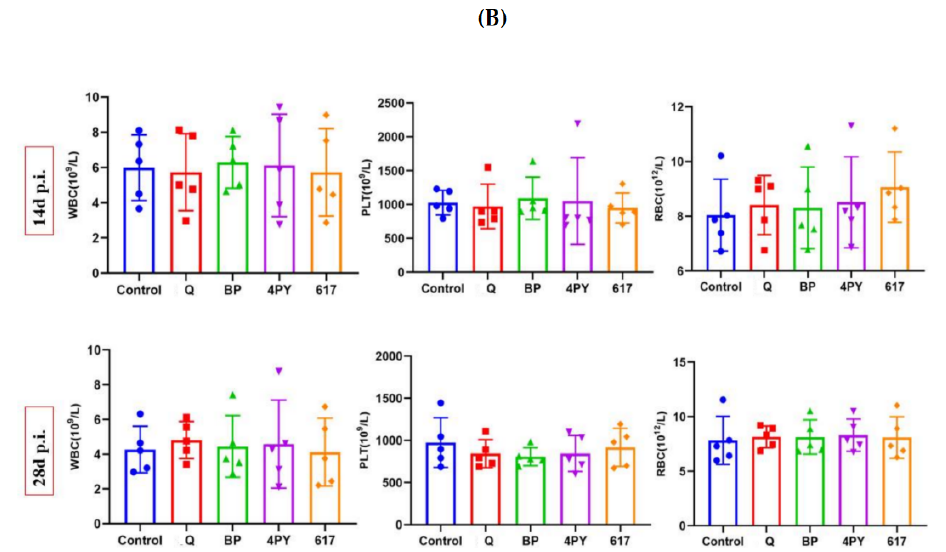
Figure 10. Radiotoxicity evaluation of [ 177 Lu]Lu-PSMA-R and [ 177 Lu]Lu-PSMA-617 (74 MBq/mouse) in ICR mice ( n = 5/group). ( A ): Results of HE staining of the main organs (kidney, heart, liver, spleen, salivary glands, small intestine, bladder, lung) of mice in the experimental and control groups ( B ): Results of routine blood tests of mice in the experimental and control groups. (WBC: white blood cell count, PLT: platelet counts, RBC: red blood cell count. Values were expressed as the mean ± SD, n = 10, ns means not statistically significant).